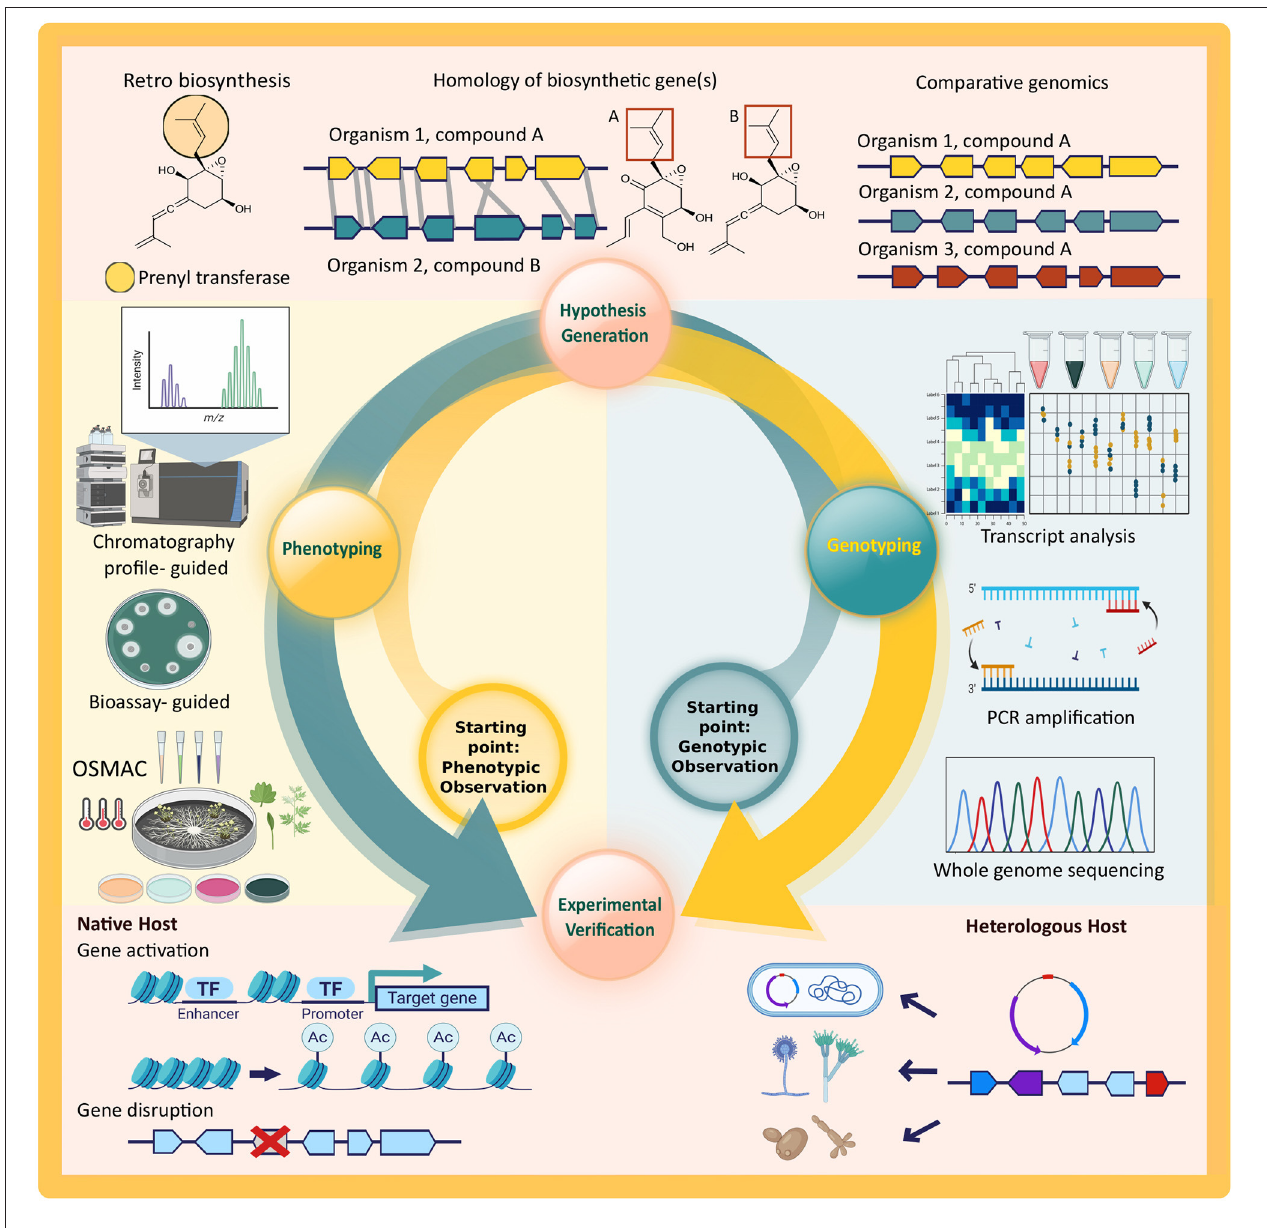
FIGURE 1 | Schematic overview of secondary metabolite discovery and pathway elucidation steps discussed in this review. All steps of the cycle are required to fully connect phenotypic observations to the genotype of an organism and vice versa. Key technologies depicted for each step are: whole genome sequencing (WGS), amplicon sequencing after PCR amplification, and transcriptomics and reverse transcriptase quantitative PCR (RT-qPCR) for genotyping; retro-biosynthesis, homology searches, and comparative genomics to generate hypotheses on the link between genotype and phenotype and vice versa; chromatography- and bioassay-guided metabolite discovery and analysis, possibly coupled to differential culturing of the native host (OSMAC) for phenotyping; gene activation and deletion in the native host as well as recombinant expression of target genes in heterologous hosts for experimental verification. Created with graphical elements from